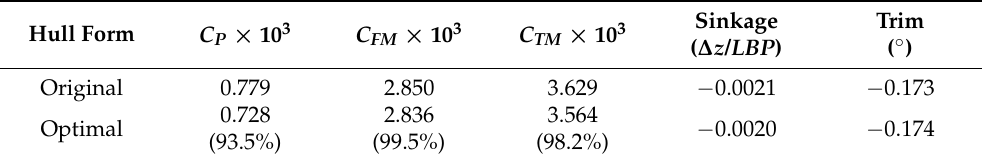
Table 10. CFD validation with respect to running attitude conditions for the optimal